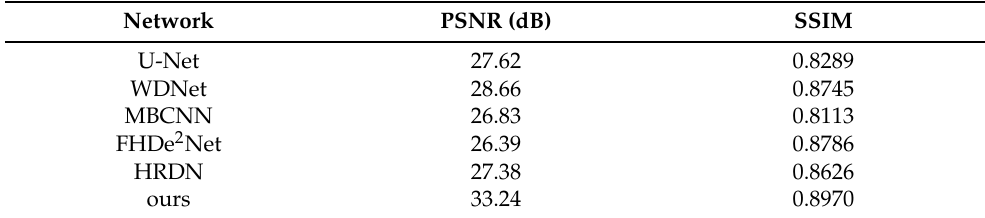
Table 1. The comparison of qualitative results between our proposed FSD-Net and other methods.